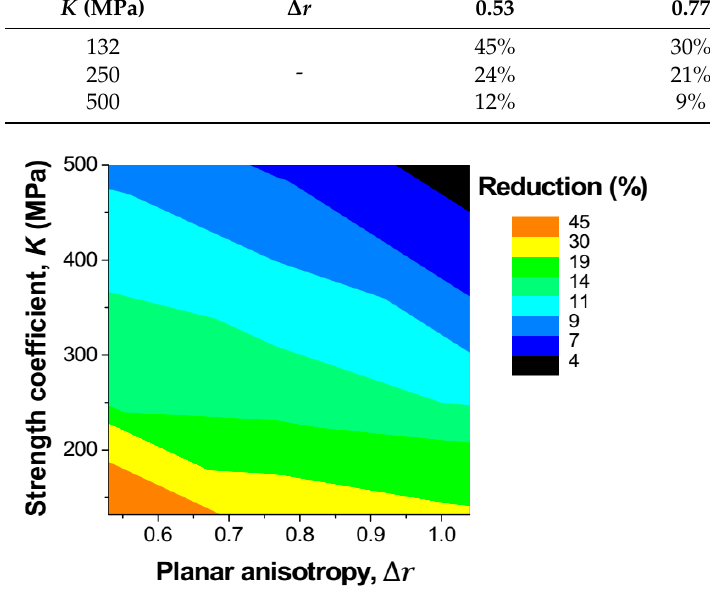
Figure 20. Effect of strength coefficient, K , and planar anisotropy, Δ r , on the reduction of earing height variation by using the varying BHF.